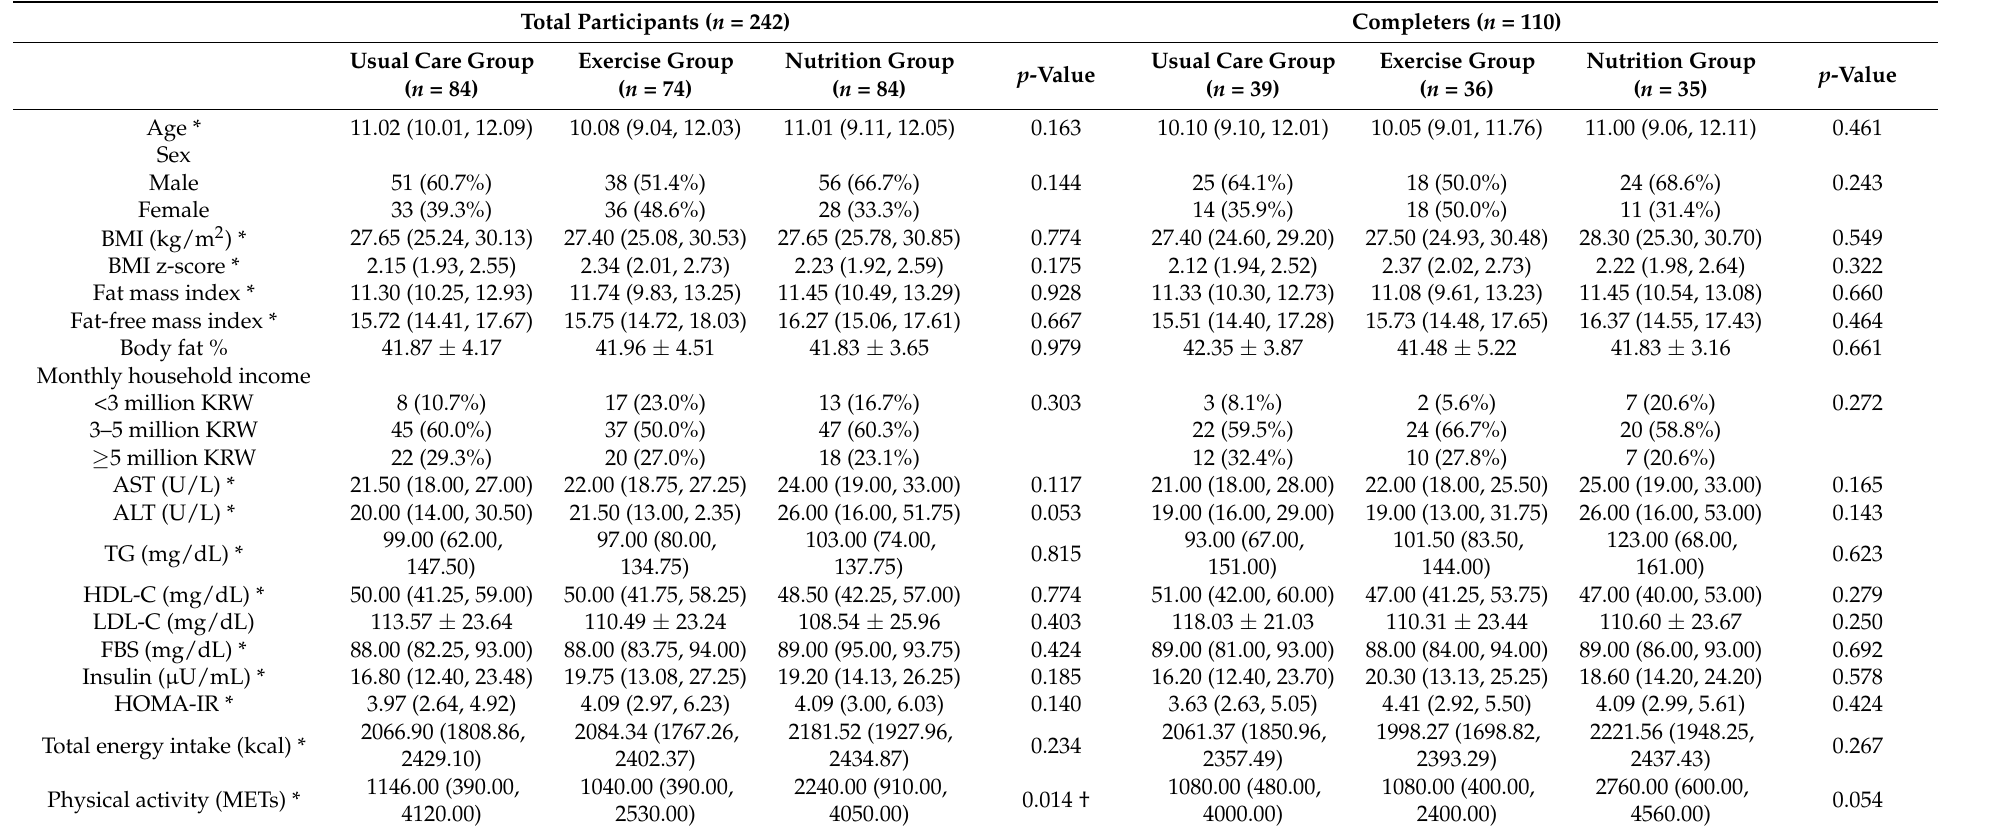
Table 1. Baseline demographic characteristics and